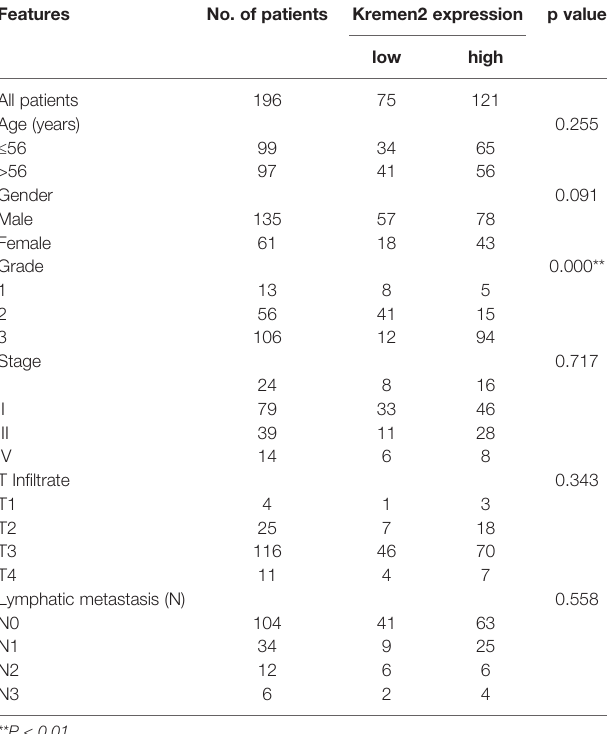
TABLE 2 | Relationship between Kremen2 expression and tumor characteristics in patients with gastric cancer. Features